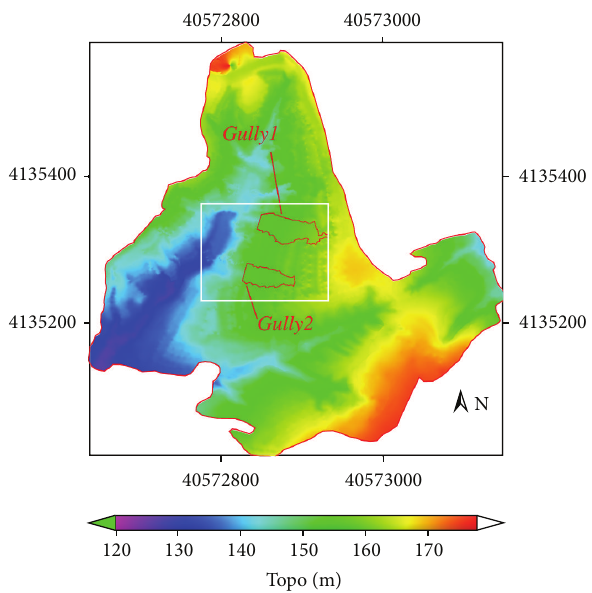
Figure 8: Fitting surface of study gullies (Gully 1, Gully 2) overlaid on the DEM raster